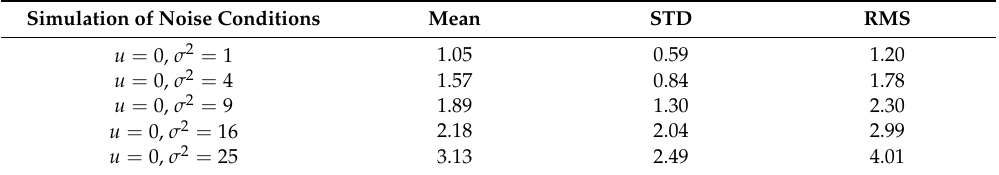
Table 4. Matching location accuracy in the simulation with mean = 0 mGal and varying variance.